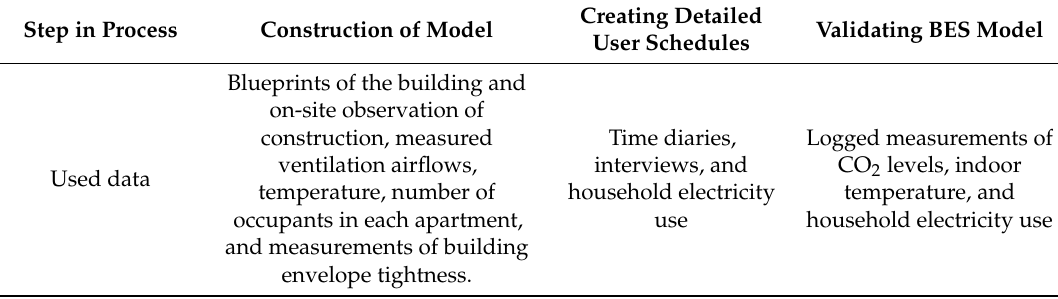
Table 6. Part of the process in which the gathered data were used. BES—building energy